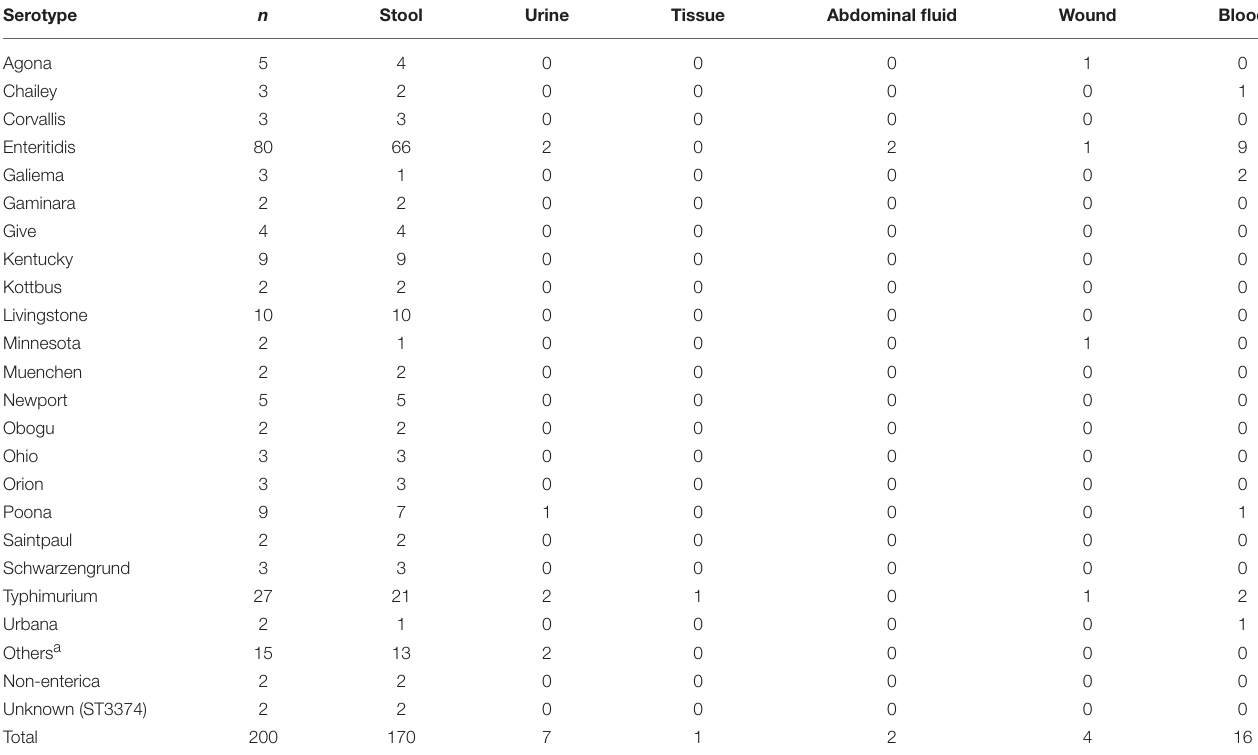
TABLE 3 | Prevalence of Salmonella serotypes based on the source of the clinical sample. Serotype n Stool Urine Tissue Abdominal fluid Wound Blood Agona 5 4 0 0 0 0 Chailey